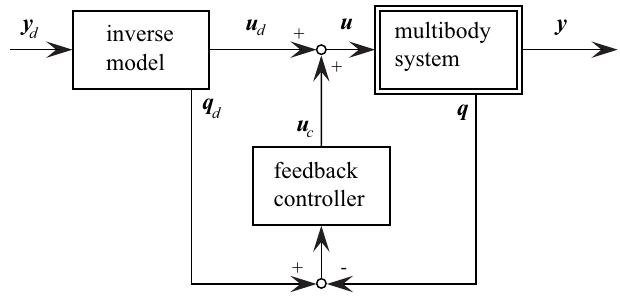
Figure 1. Control structure with feedforward and feedback con-